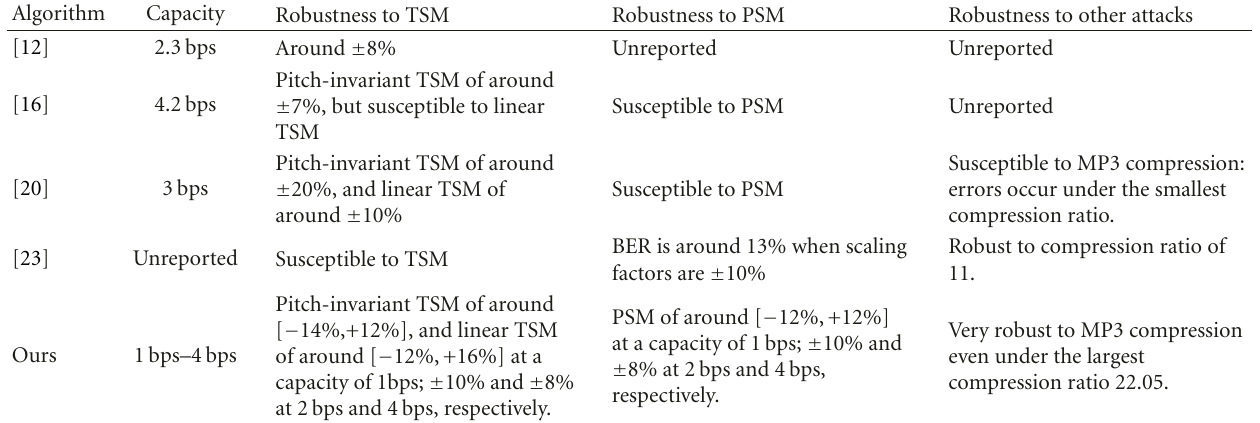
Table 5: Comparison with other